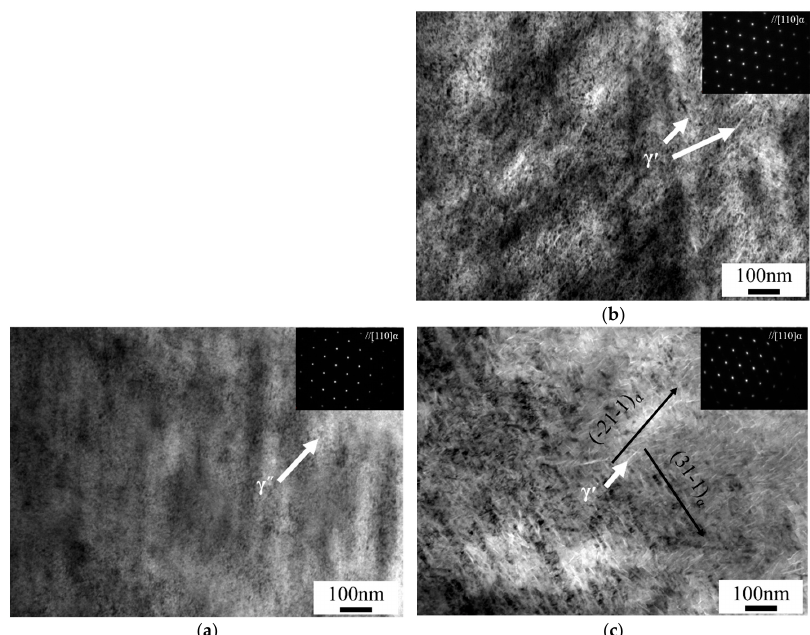
Figure 12. High-resolution transmission electron microscope (HR-TEM) images and selected area diffraction pattern (SADP) outcomes of the post-weld heat treated foils: ( a ) 0.5 hour, ( b ) three hours and ( c ) eight hours.